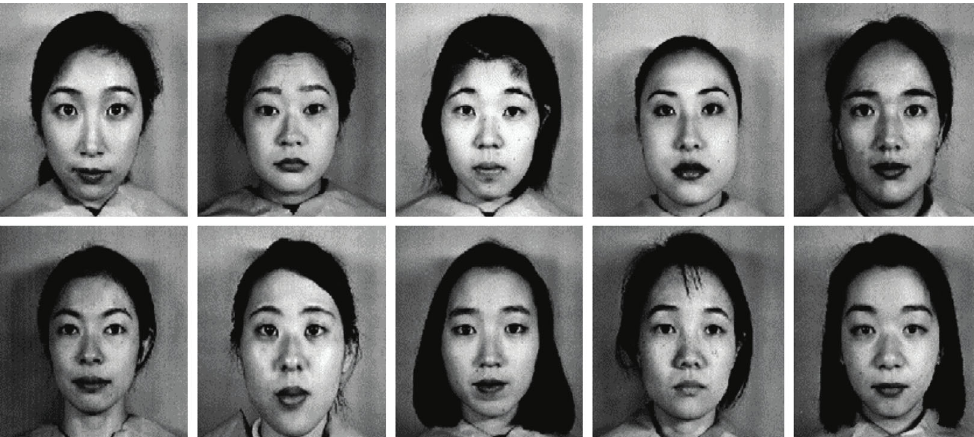
Figure 2: Sample of subject in the JAFFE database.